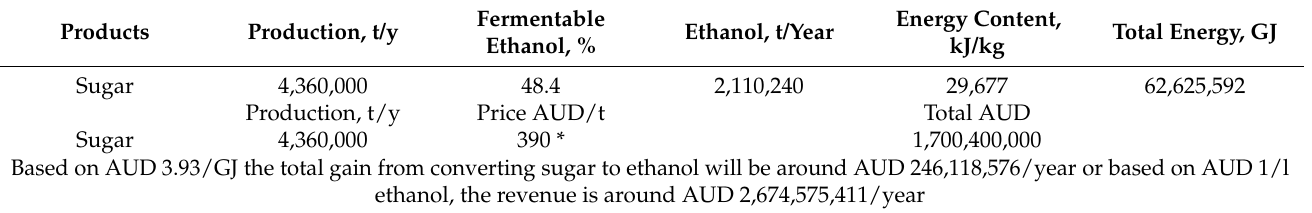
Table 35. Ethanol production from